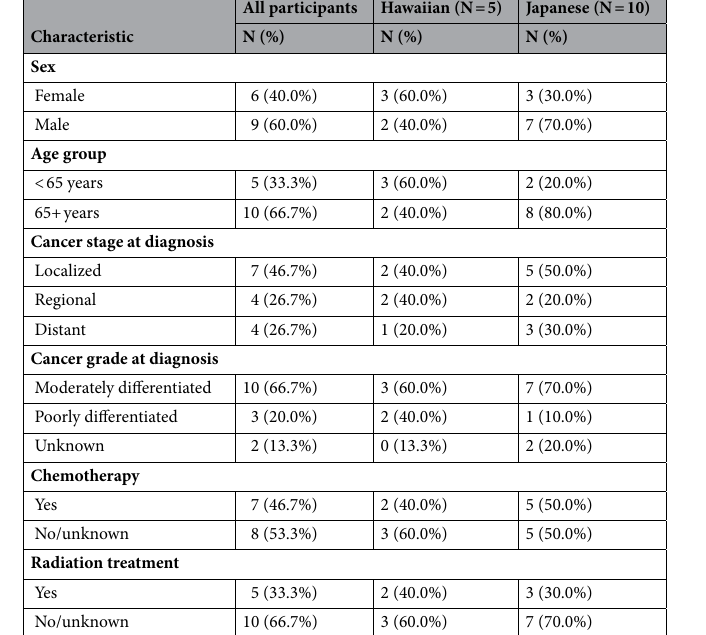
Table 2. Baseline and tumor characteristics of study